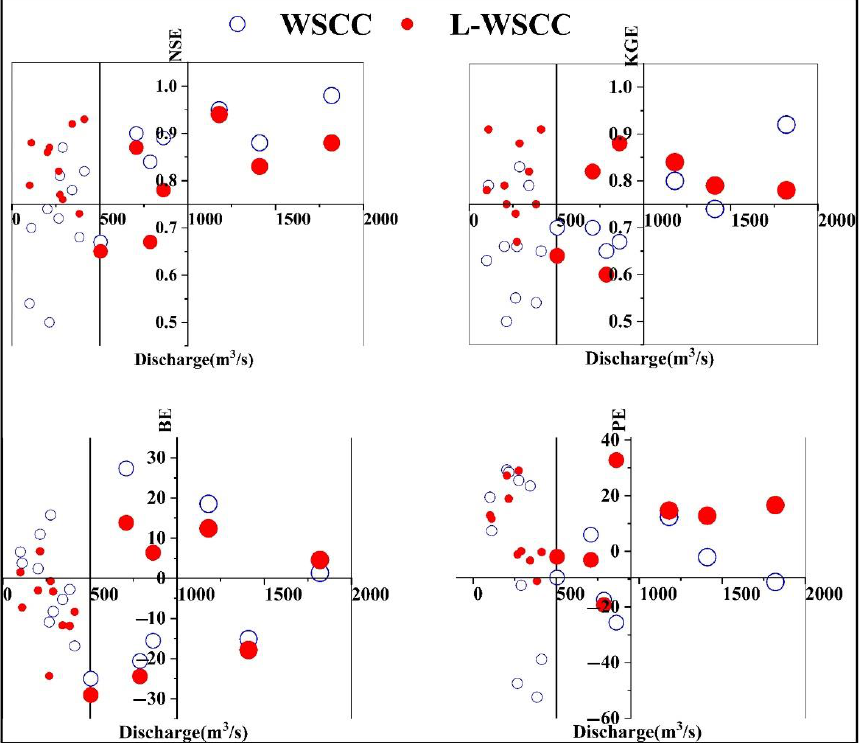
Figure 6. The distribution of evaluation results under different types of floods (in turn: NSE, KGE, BE, PE). The point size represents different flood discharge.